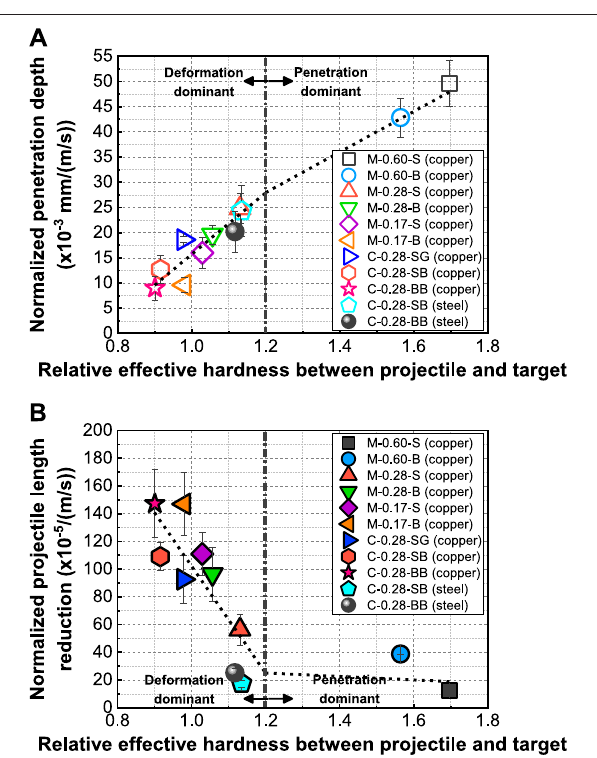
FIGURE 15 | Variation of (A) the normalized DOP and (B) the projectile length reduction with respect to the REH.